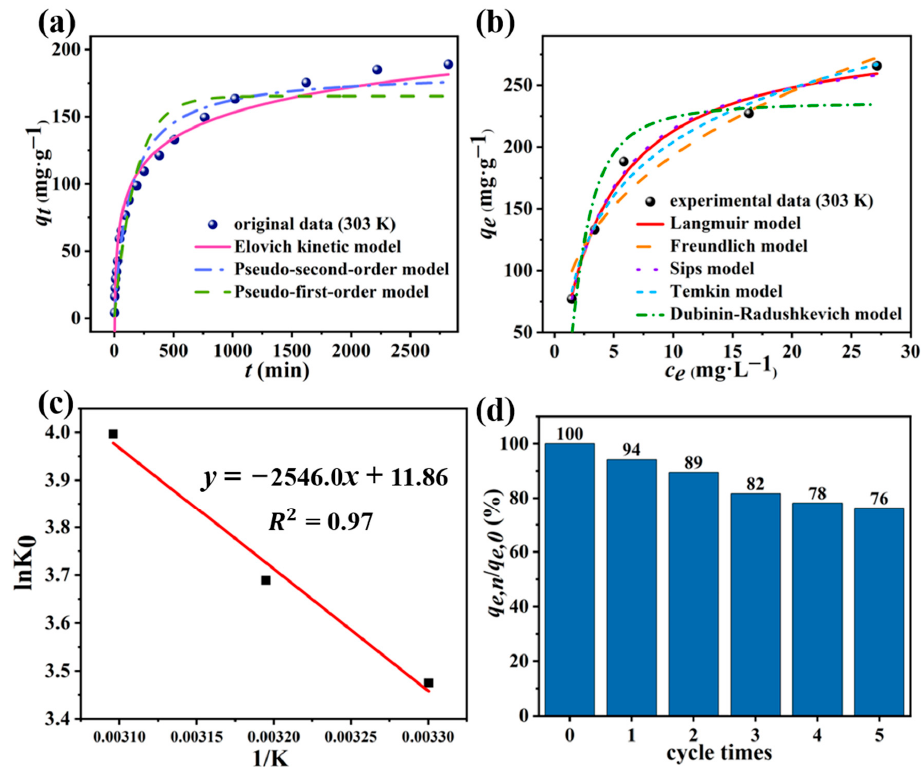
Figure 7. ( a ) Adsorption kinetics curves; ( b ) adsorption isotherm curves; ( c ) fitting results of thermodynamic calculation; ( d ) regeneration performance. Table 3. Results for parameters and the information criterion determination of kinetic